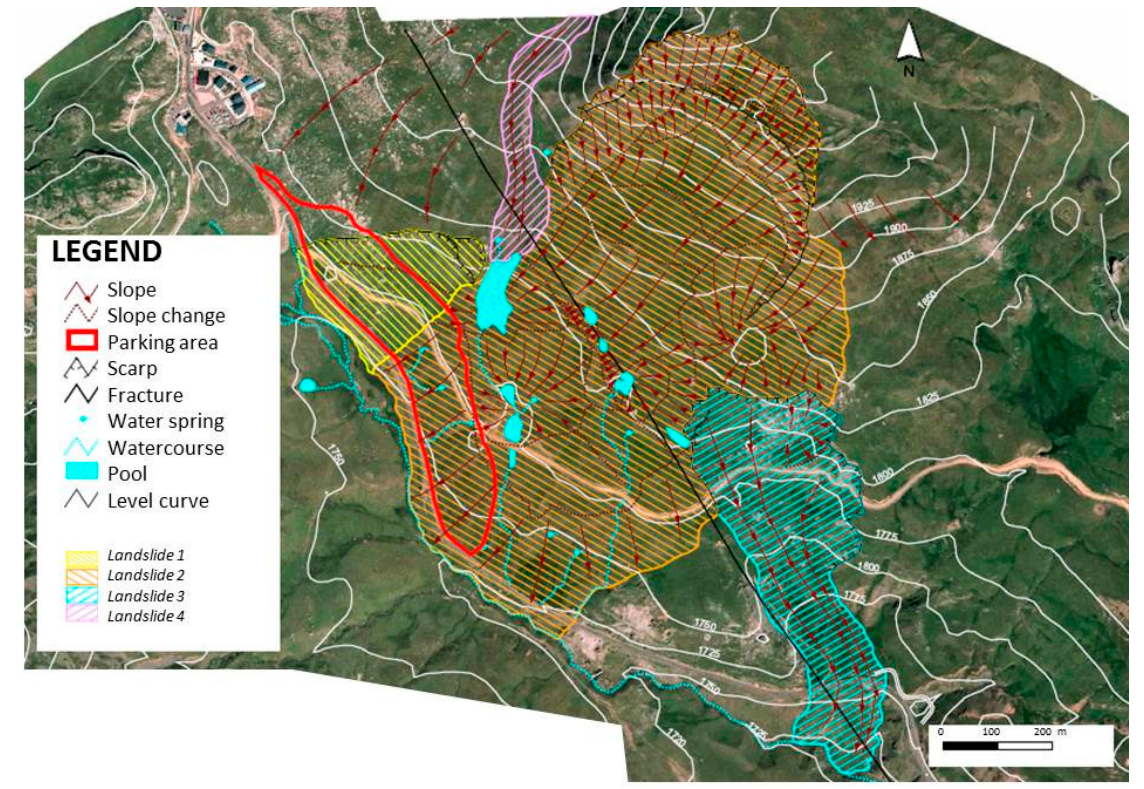
Figure 8. Main landslides detected in the area under study.